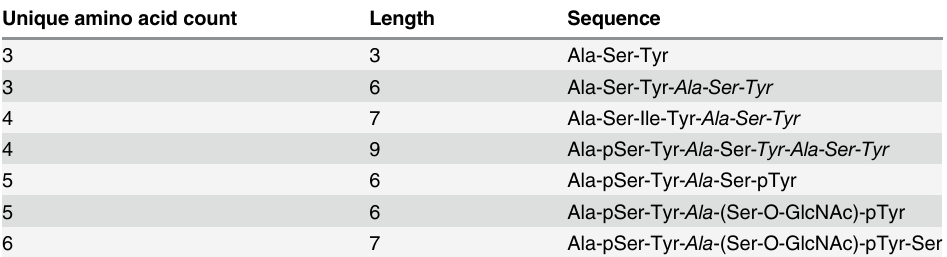
Table 1. The unique amino acid count defined for seven peptide sequences, including PTM amino acids. Italicised amino acids are repetitions in the same sequence. Abbreviations: Ala, Alanine; Ser, Serine; Tyr, Tyrosine; Ile, Isoleucine; pSer, phosphoserine; pTyr, phosphotyrosine; (Ser-O-GlcNAc), N-Acetylgluco- samine-O-linked Serine Unique amino acid count